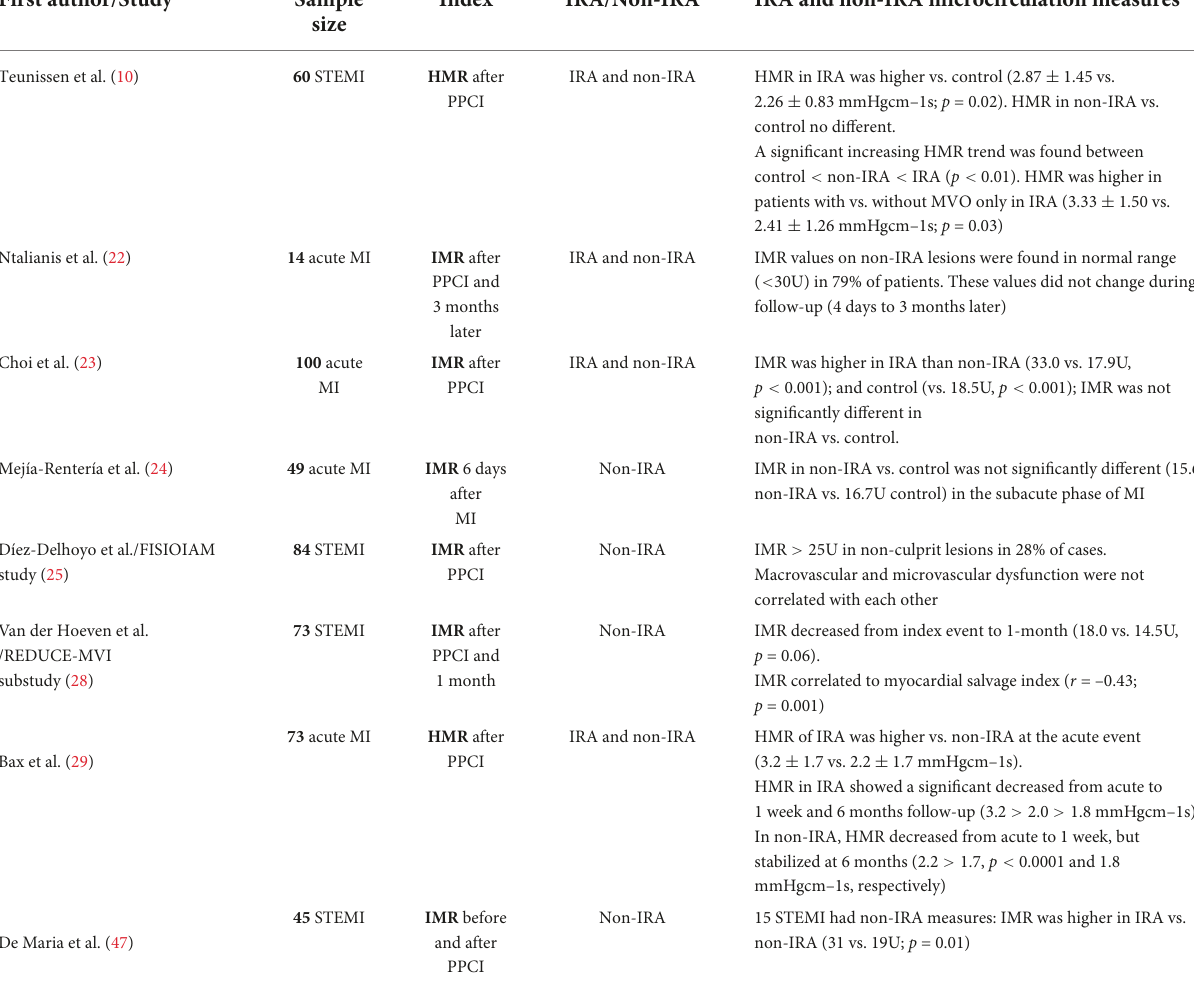
TABLE 3 Non-randomized controlled trials of microvascular resistance indices in acute MI measured in non- infarcted